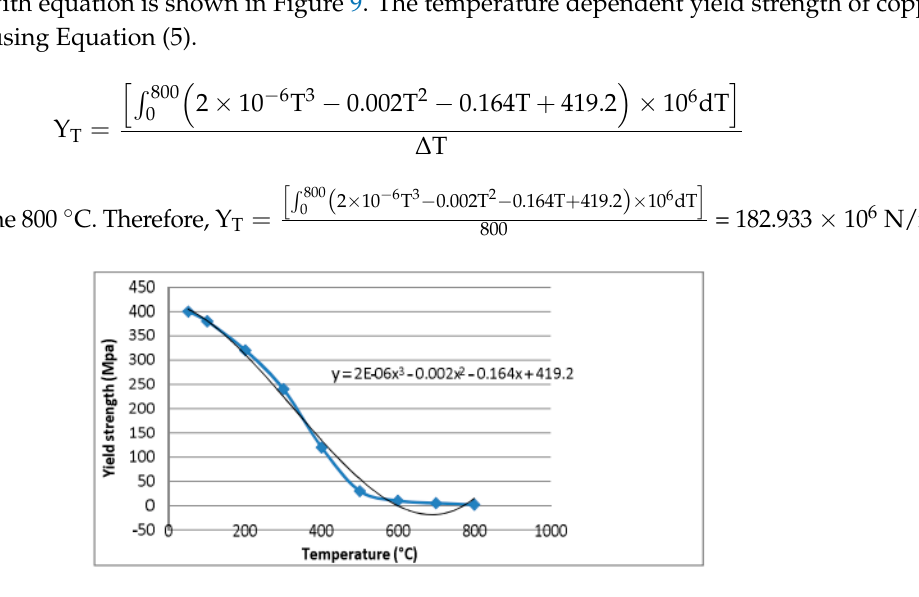
Figure 9. Temperature dependent yield strength of copper.